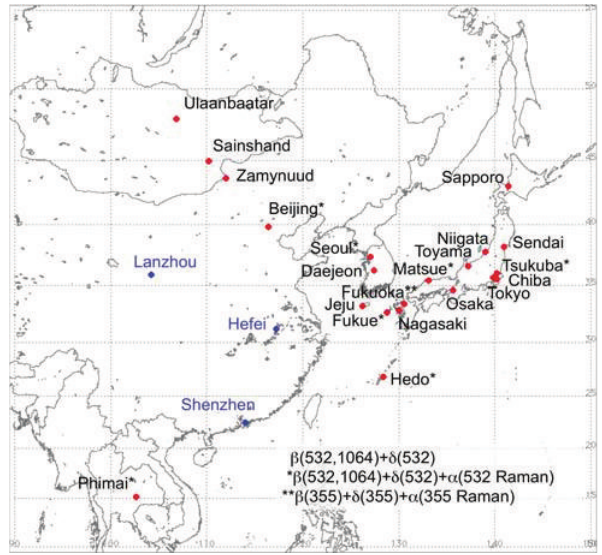
Figure 5: Lidar observation network in East Asia